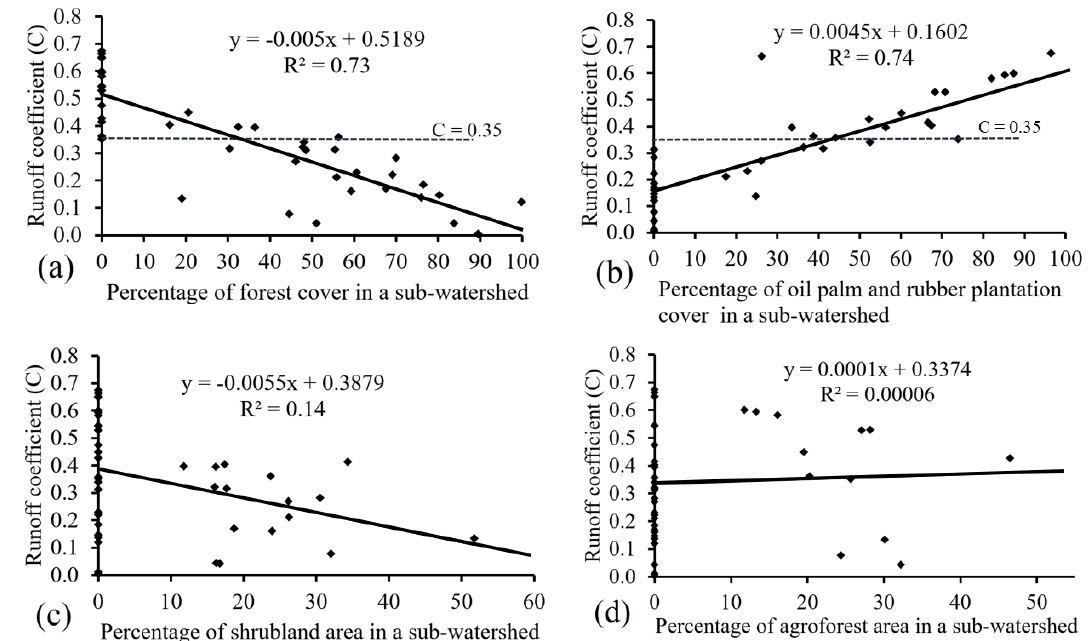
Figure 5. Association between simulated C values and the percentage of each land use type in a particular sub-watershed. Dotted lines indicate the maximum acceptable C value according to the Ministry of Forestry Decree